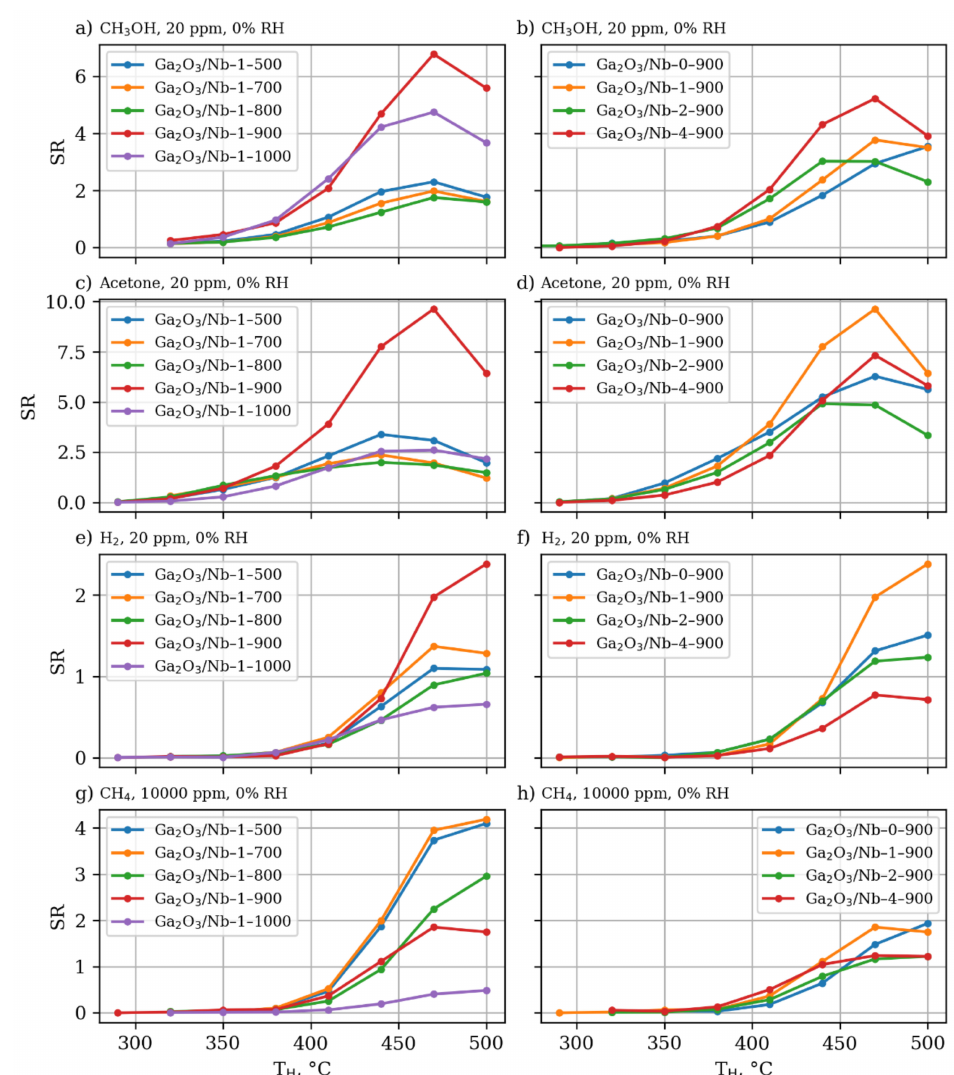
Figure 8. Dependence of sensor response of Ga 2 O 3 -based materials towards reducing gases and volatile organic compounds (VOCs) on temperature in relation to materials annealing temperature and Nb content—( a ) sensor response of Ga 2 O 3 -based materials doped with 1% mol Nb and annealed at different temperatures towards 20 ppm of methanol in dry air ( b ) sensor response of Ga 2 O 3 -based materials doped with various mol content of Nb and annealed at 900 ◦ C temperature towards 20 ppm of methanol in dry air ( c ) sensor response of Ga 2 O 3 -based materials doped with 1% mol Nb and anneald at different temperatures towards 20 ppm of methanol in dry air ( d ) sensor response of Ga 2 O 3 -based materials doped with various mol content of Nb and annealed at 900 ◦ C temperature towards 20 ppm of acetone in dry air ( e ) sensor response of Ga 2 O 3 -based materials doped with 1% mol Nb and anneald at different temperatures towards 20 ppm of hydrogen in dry air ( f ) sensor response of Ga 2 O 3 -based materials doped with various mol content of Nb and annealed at 900 ◦ C temperature towards 20 ppm of hydrogen in dry air ( g ) sensor response of Ga 2 O 3 -based materials doped with 1% mol Nb and anneald at different temperatures towards 10,000 ppm of methane in dry air ( h ) sensor response of Ga 2 O 3 -based materials doped with various mol content of Nb and annealed at 900 ◦ C temperature towards 10,000 ppm of methane in dry